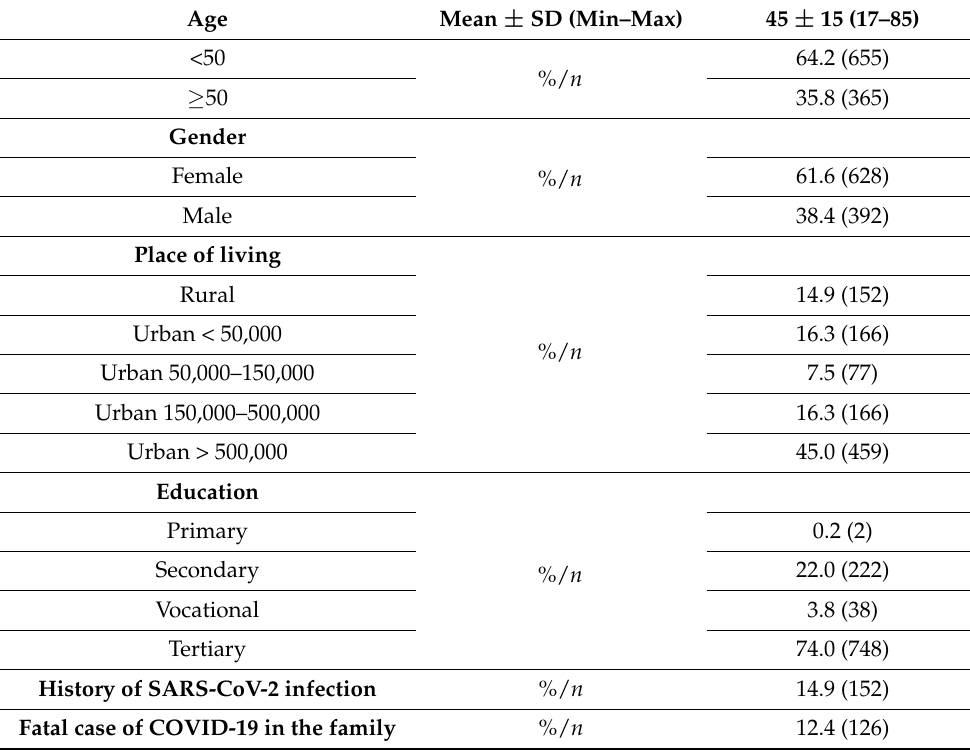
Table 1. The demographic characteristic of the studied group ( n =